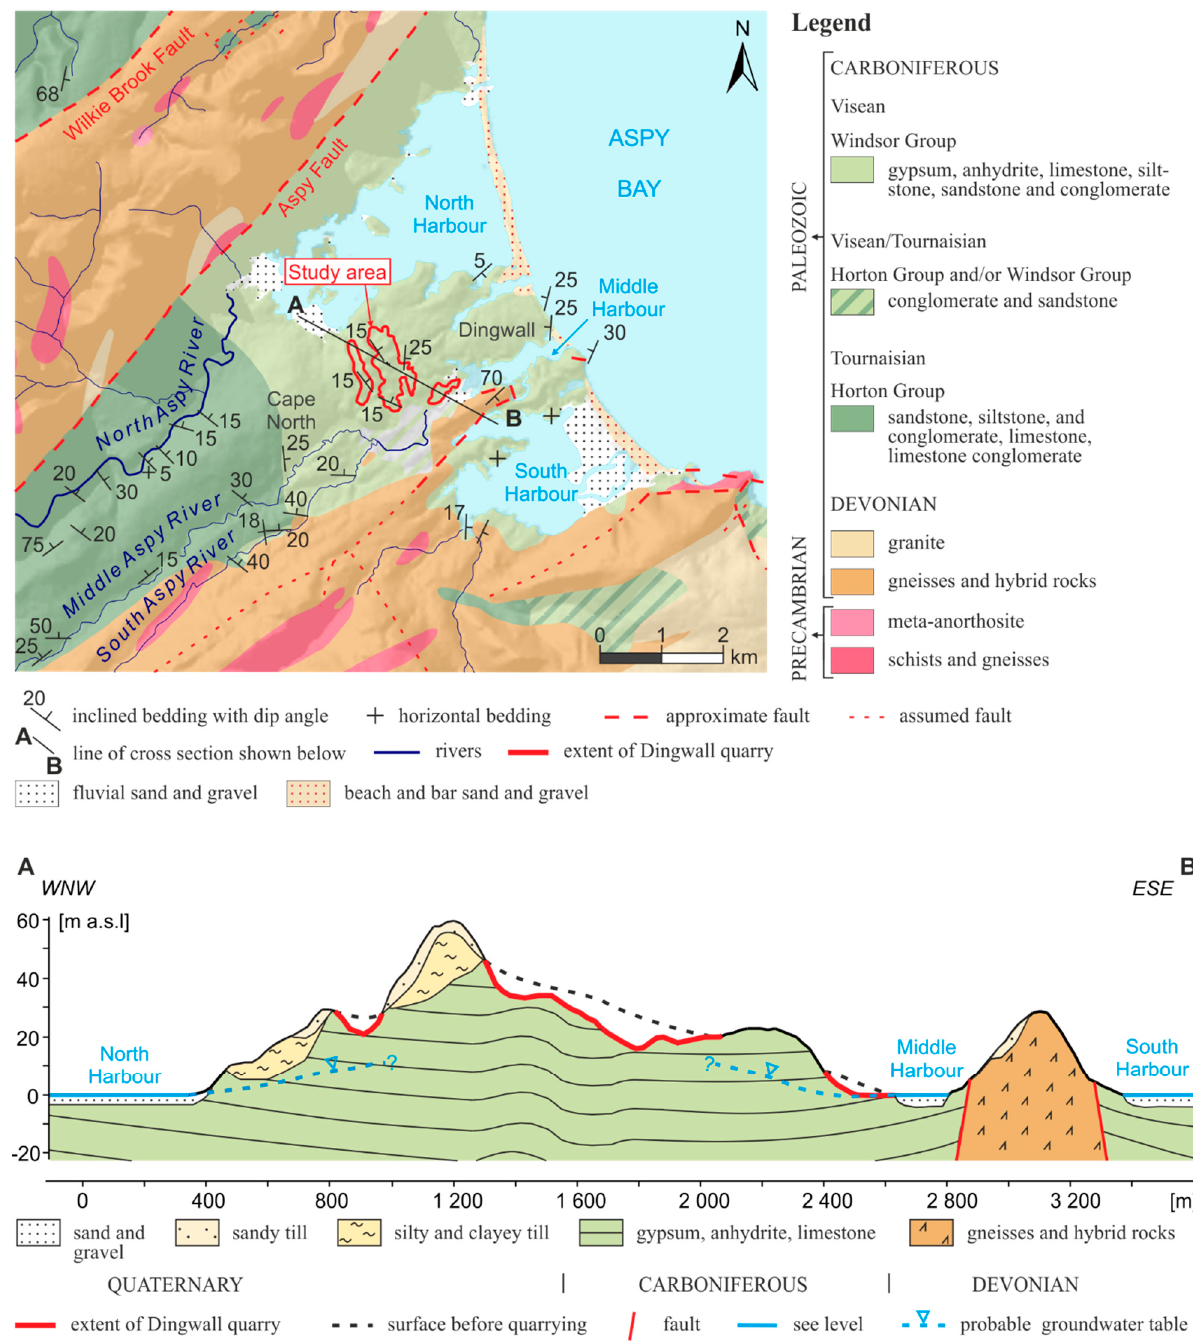
Figure 2. Geological map of nearest area of the Dingwall quarry (after [47,48]) and geological cross section through A–B line, cross-section contains also Quaternary deposits not shown on the map [47,48,51].